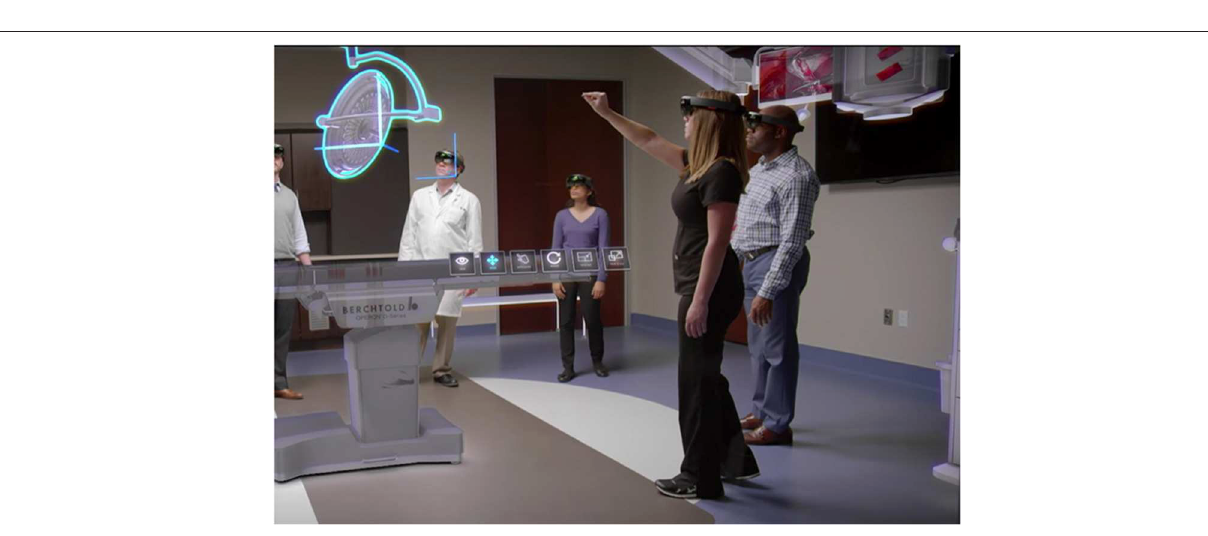
FIGURE 5 | A mixed reality scenario showing five co-located users collaboratively interacting with a virtual environment (Image source,